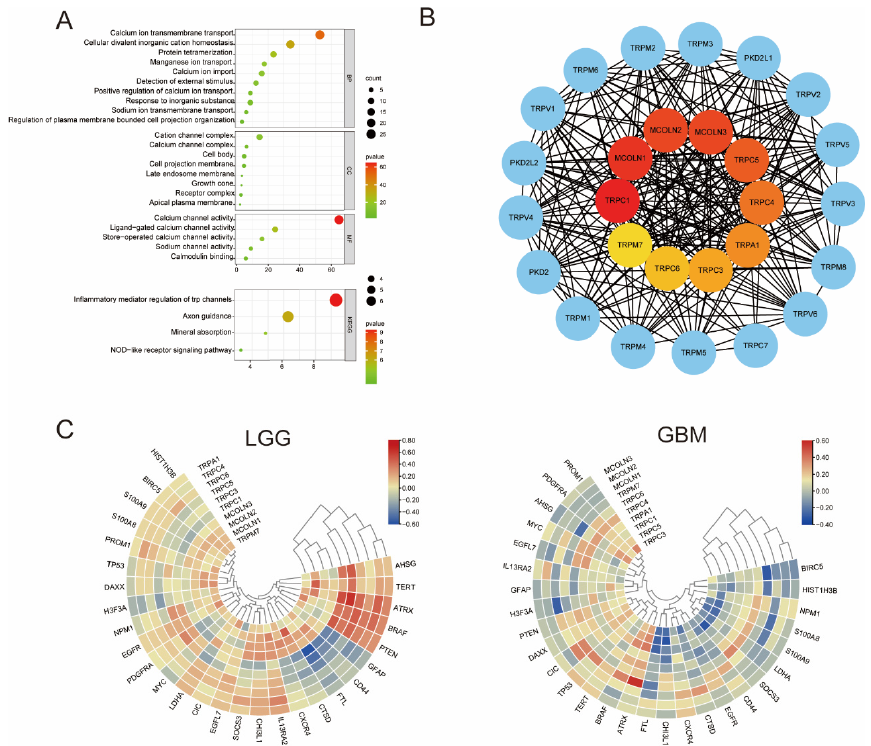
Figure 2. GO and KEGG enrichment analysis and hub genes of the TRP family in glioma. ( A ) The bubble plot shows the most enriched GO and KEGG pathways of target genes. Three factors were considered in the GO enrichment analysis, including BP, CC, and MF. Additionally, the most significant KEGG pathways involved inflammatory and their signaling pathways. ( B ) By using CytoHubba based on the MCC algorithm, the top 10 of the hub genes were identified in the center of the diagram. Additionally, the importance of genes was represented by different colors; red to yellow represent the decreasing importance of the hub genes, while blue was excluded from hub genes. ( C ) Heatmap representing the correlations between hub genes of TRP family and 28 biomarkers in glioma.